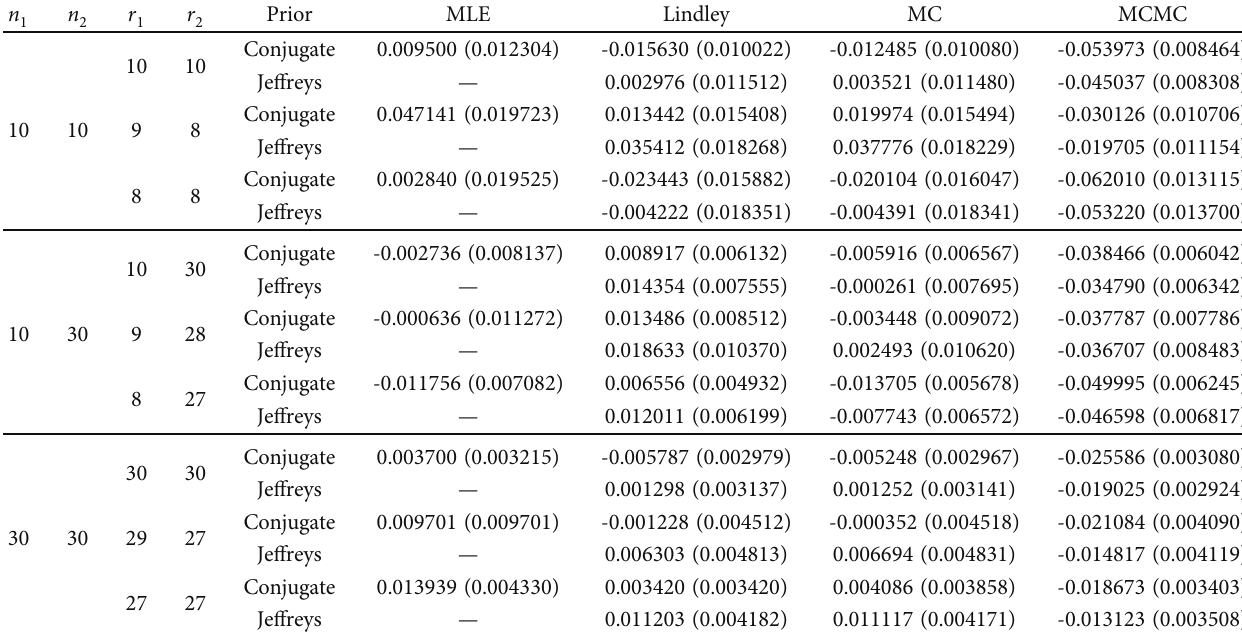
= 1, β = 2, γ = 1, R = 2/3 . 1 2